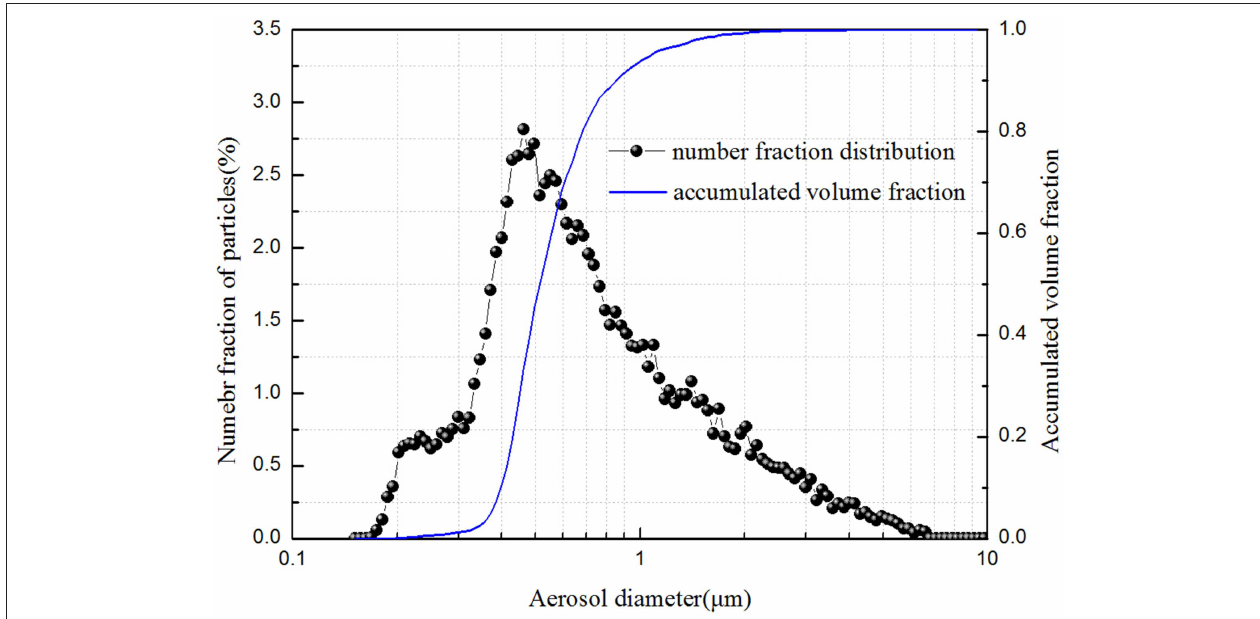
FIGURE 2 | Typical size distribution of Barium sulfate particles.